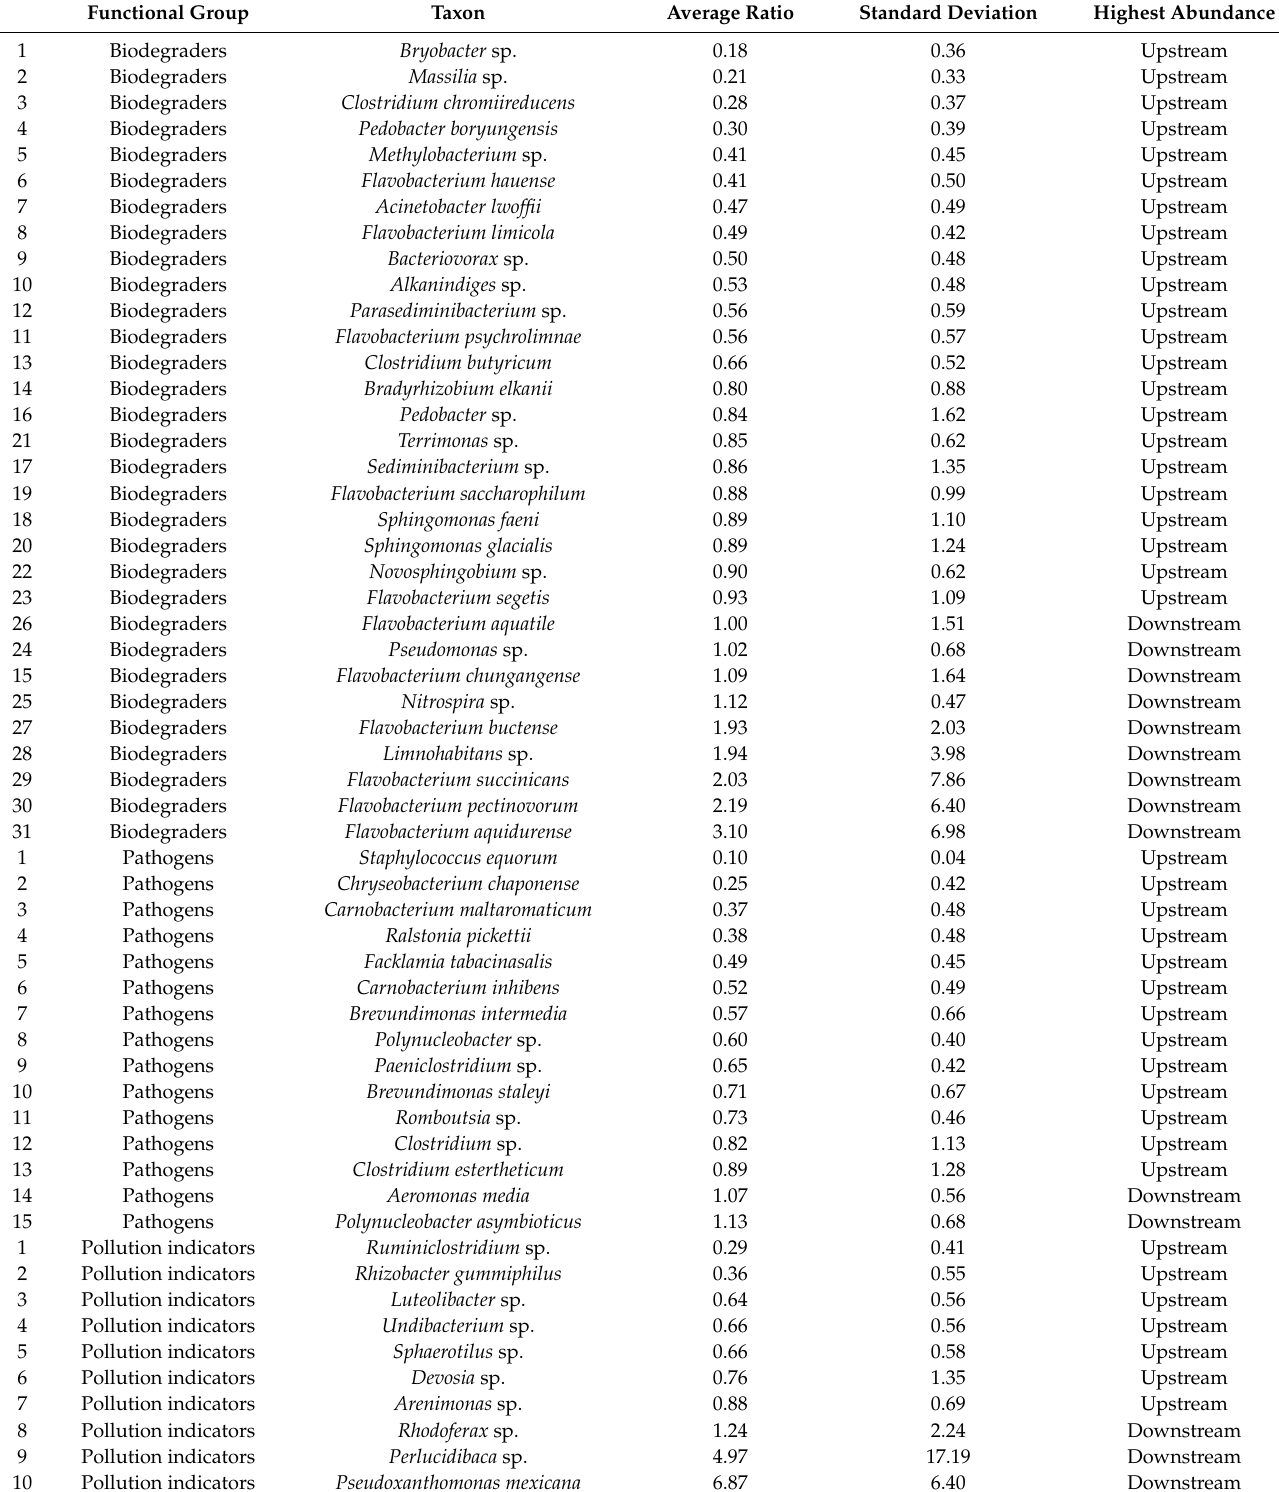
Table 2. Bacteria taxa (relative abundance > 1%) for which a significant change ( p < 0.05) in relative abundance was detected between upstream and downstream locations across all sampling sites and periods. Ratios were calculated per site and averaged. The complete taxonomic affiliation for each taxon, the p value, and additional taxa that did not have a significant change between upstream and downstream locations are provided in Table